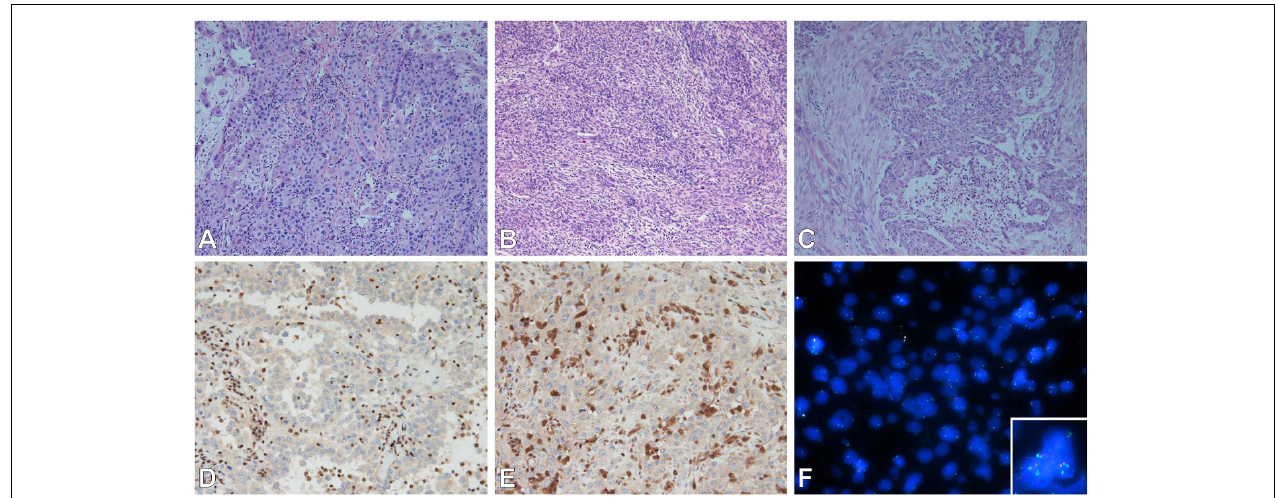
FIGURE 1 | (A–C) Subtypes of mesothelioma. (A) Epithelioid, (B) sarcomatoid, (C) biphasic. Epithelioid subtype with BAP-1 (D) , MTAP (E) immunohistochemistry (loss of nuclear and cytoplasmic staining respectively); and FISH (F) of MTAP/CDKN2A/CEP9 tricolor probes (MTAP – Aqua, CDKN2A – Red, CEP9 – Green) showing loss of MTAP and CDKN2A (inset normal signals for comparison). Images (A–E) were taken by Olympus microscope with 20 × objective, image (F) was taken by ZEISS Axio.M2 microscope with 63 × objective.